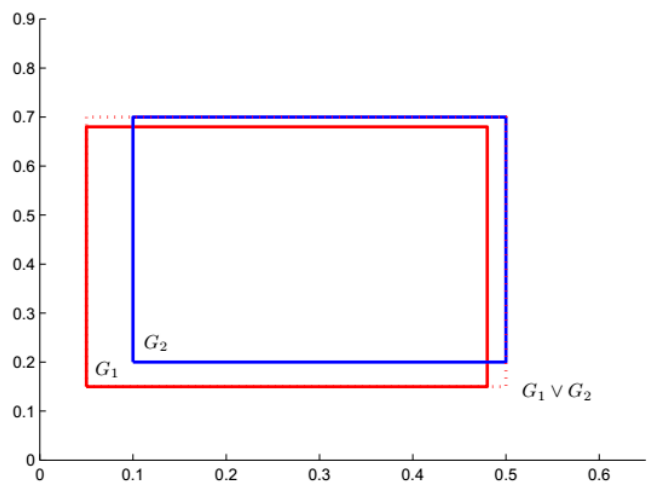
Figure 1. Join process of two hyperbox granules in 2-D space.